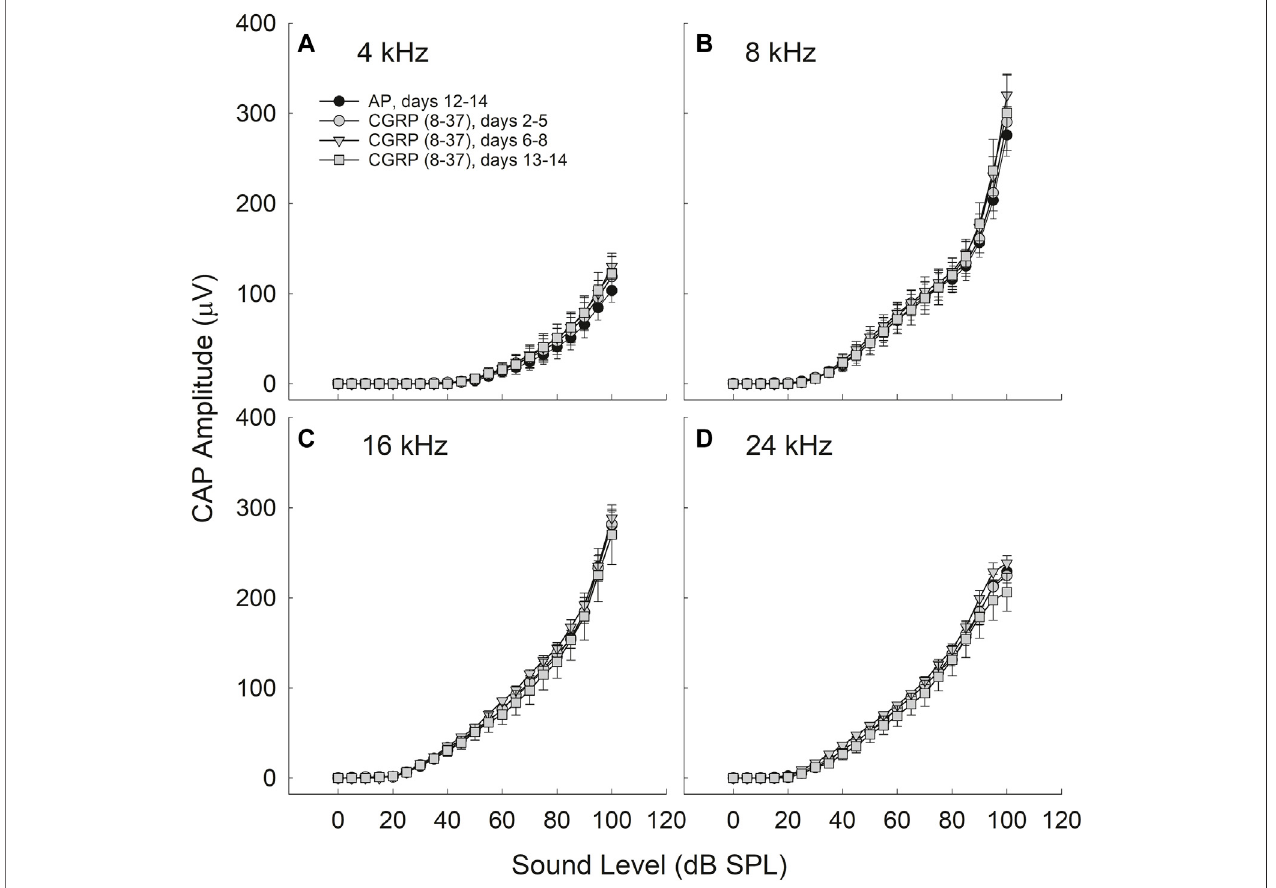
FIGURE 3 | CAP amplitude did not change as a function of CGRP (8 – 37) infusion at 4 (A) , 8 (B) , 16 (C) , and 24 (D) kHz. CAP tests were conducted at least once from days 2 – 5, on days 6, 7, or 8, and on days 13 or 14 for CGRP (8 – 37). All comparisons are relative to control measurements on the 12th – 14th day of arti fi cial perilymph (AP) infusion, immediately prior to the pump change surgery during which the AP pump was replaced with a pump containing CGRP (8 – 37).